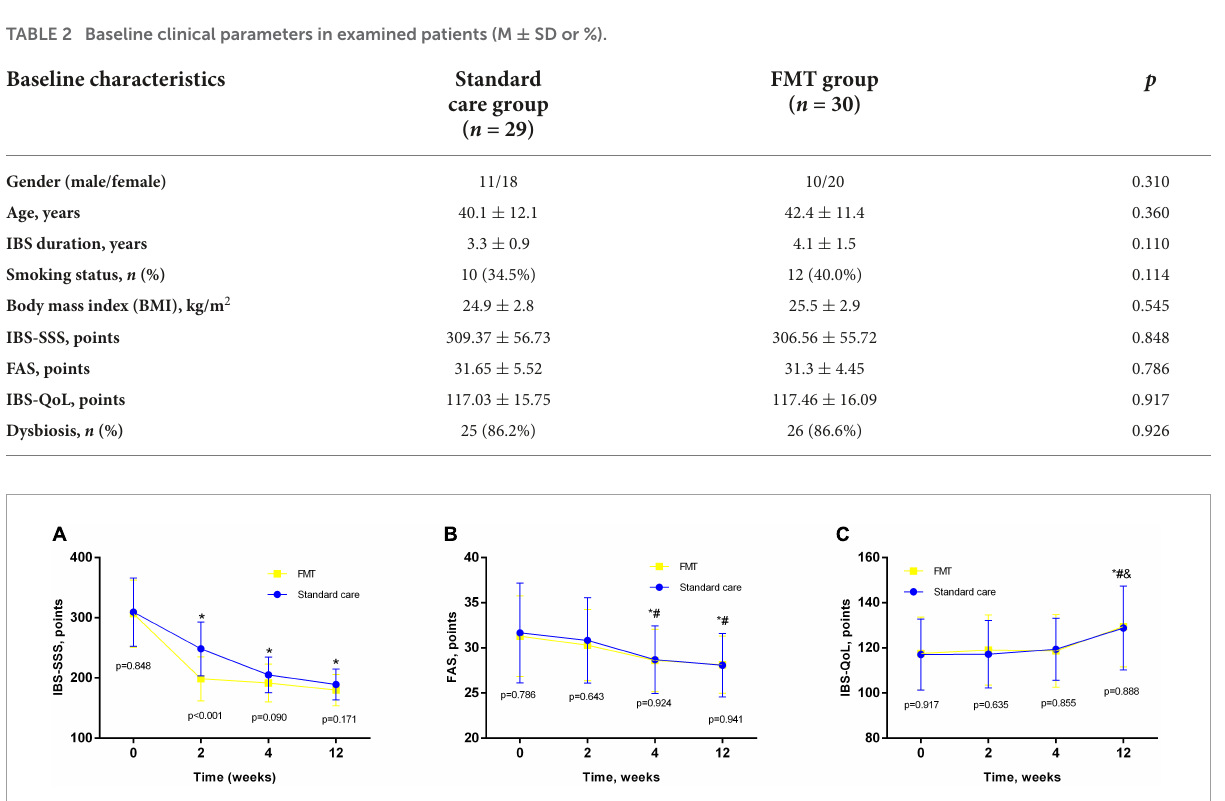
FIGURE2 Main outcomes analysis in different timepoints. (A) IBS-SSS; (B) FAS scale; (C) IBS-QoL scale. Data expressed as mean ± SD. RM-ANOVA was used to identify any differences within groups. p indicates the difference between groups at the same timepoint. *, as compared to baseline; #, compared to 2 week; &, compared to 4